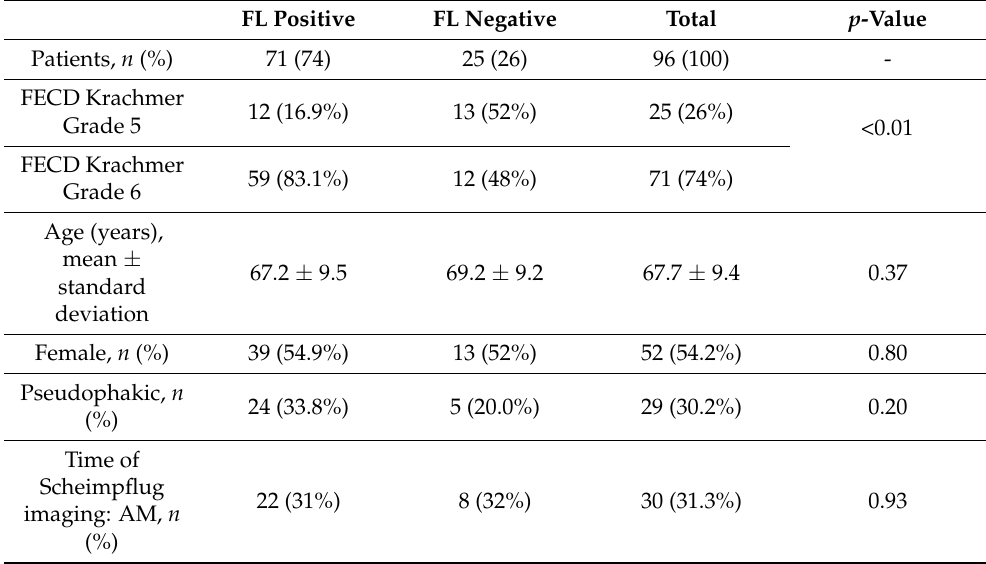
Table 1. Characteristics of patients and investigated eyes (one eye per patient), fibrillar layer